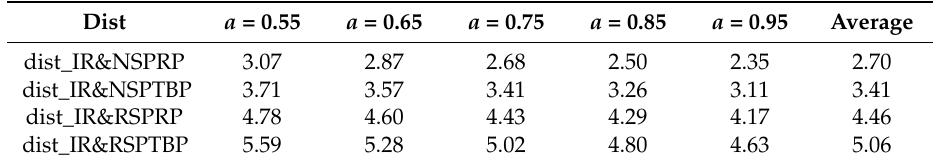
Table 4. Trajectory similarities between IR and NSPRP/NSPTBP/RSPRP/RSPTBP from 2010 to